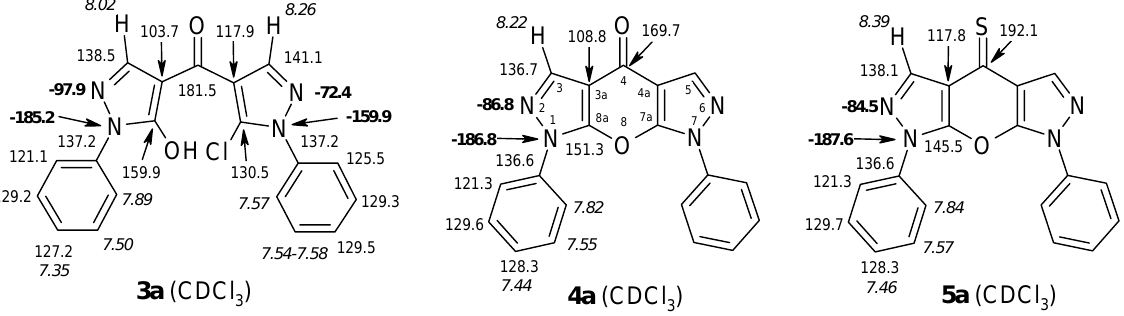
Figure 2. 1 H- ( in italics ), 13 C- and 15 N-NMR (in bold ) chemical shifts in 3a , 4a and 5a ( δ , ppm, in CDCl 3